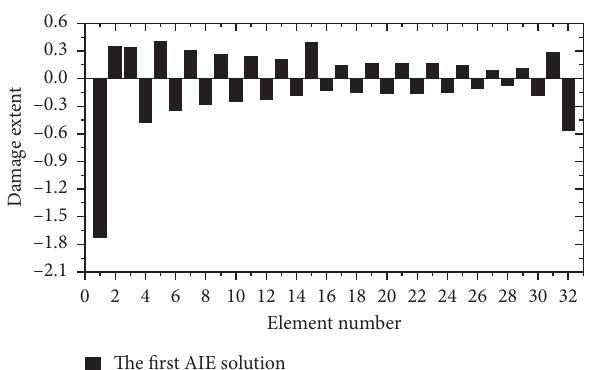
Figure 3: Damage assessment result by the first AIE when element 15 is damaged.